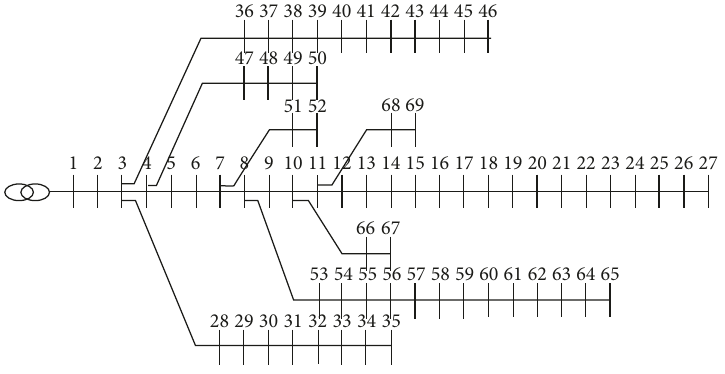
Figure 2: The 69-bus Mg